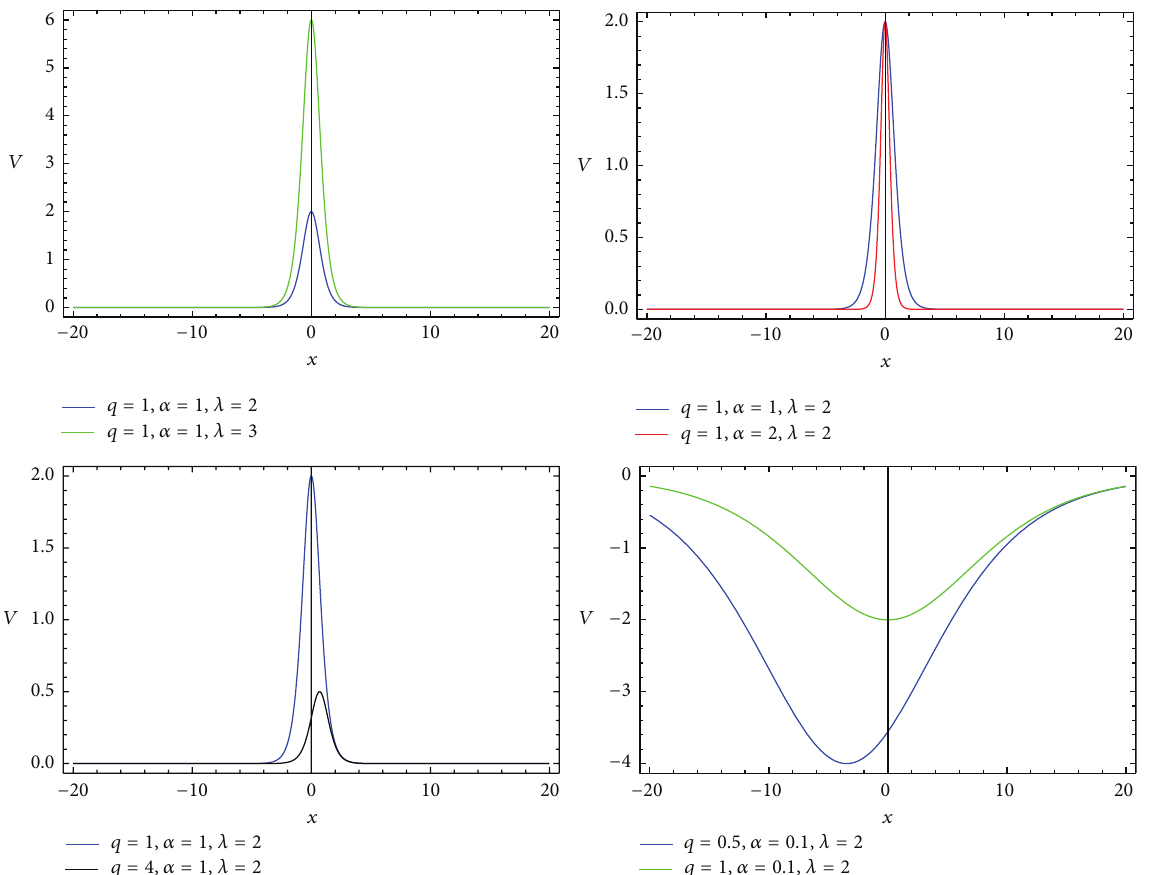
Figure 1: The graph of the 𝑞 HPT potential versus the position for different values of the potential